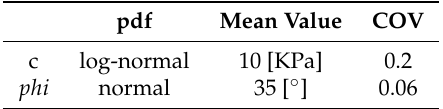
Table 3. Soil properties for the cover used in the probabilistic analyses.